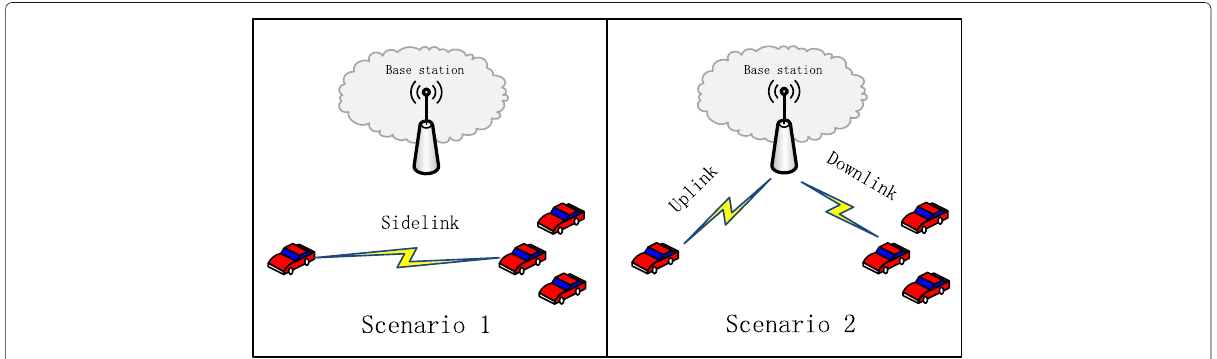
Fig. 1 Two communication scenarios for V2V. In scenario 1, data packets are transmitted directly between vehicles. In scenario 2, data packets are transferred by base